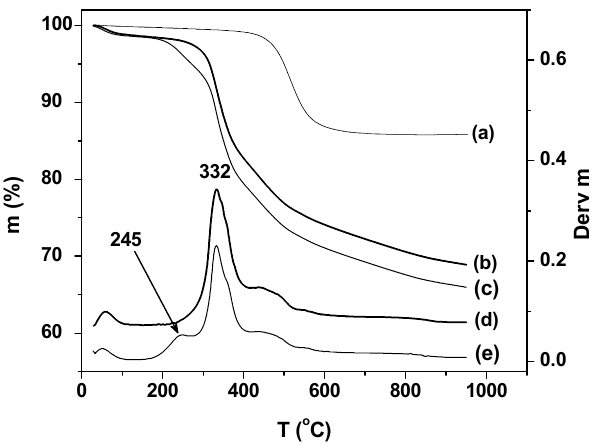
Figure 2. Thermal gravimetric analyse (TGA) curves of ( a ) kaolinite; ( b ) K-NI; ( c ) NI intercalated kaolinitewashed with isopropyl alcohol and DTGA curves of ( d ) K-NI, and ( e ) NI intercalated kaolinitewashed with isopropyl alcohol.